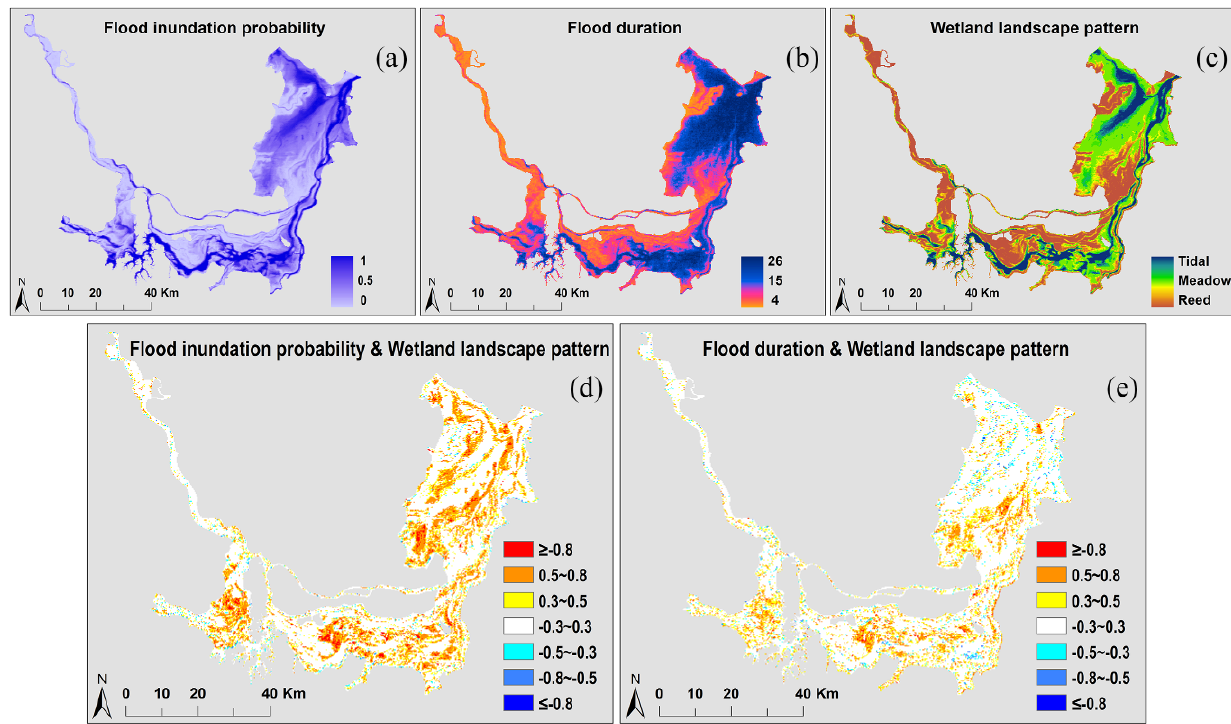
Figure 11. ( a ) Average flood inundation probability from 2000 to 2012; ( b ) Average flood duration between 2000 and 2012; ( c ) Average wetland landscape pattern over the period 2000 to 2012; ( d ) Spatial correlation between flood inundation probability and wetland landscape pattern over the period 2000 to 2012; ( e ) Spatial correlation between flood duration and wetland landscape pattern over the period 2000 to